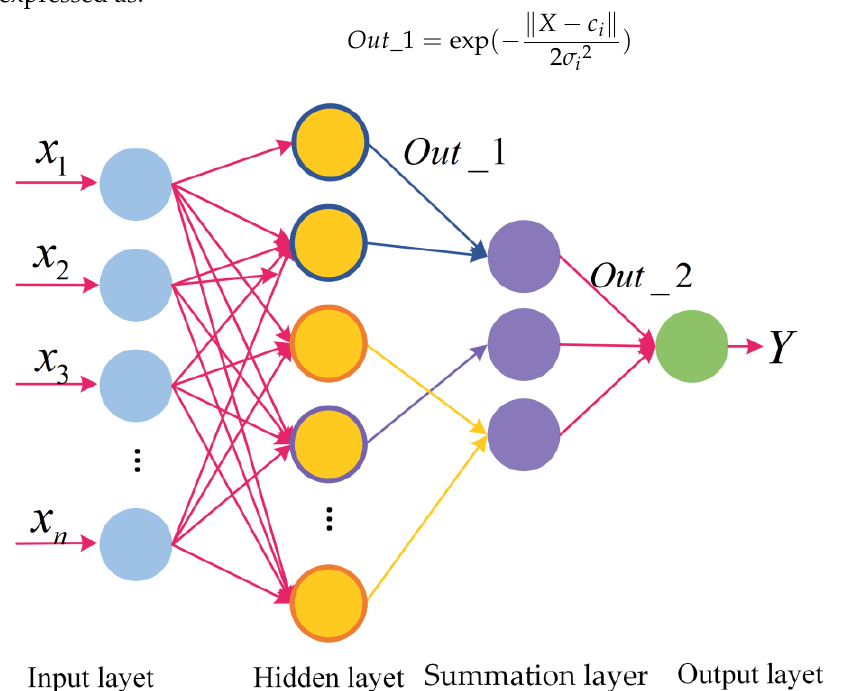
Figure 4. PNN network structure.